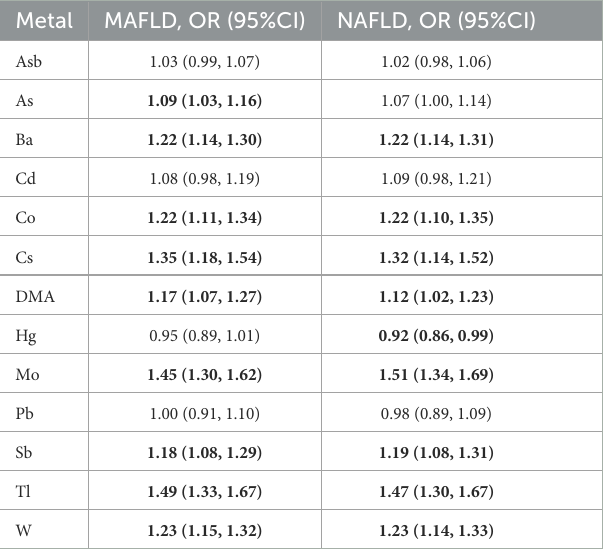
Estimates werepresentedasoddsratio(OR) and95% confidenceintervals(CIs). Themodels were adjusted for age, gender, race, research cycle, education level, smoking status, PIR, and physicalactivity.BoldfontforP < 0.05.